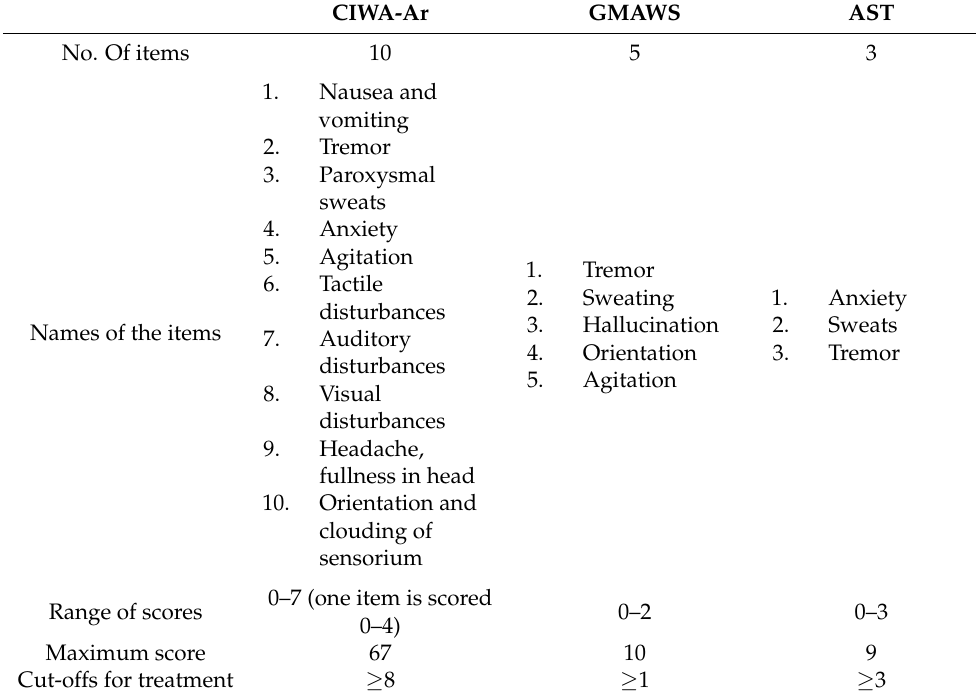
Table 1. Comparison of Alcohol Withdrawal